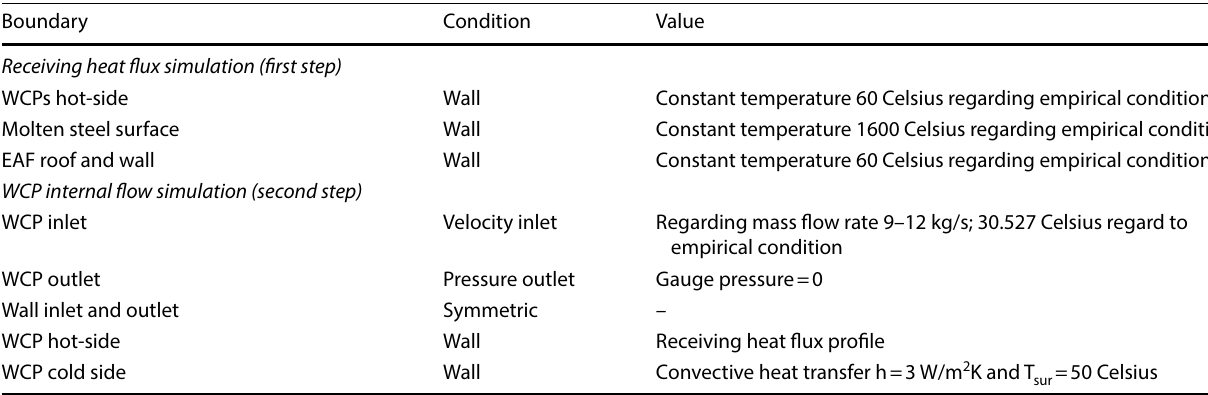
Table 5 Boundary